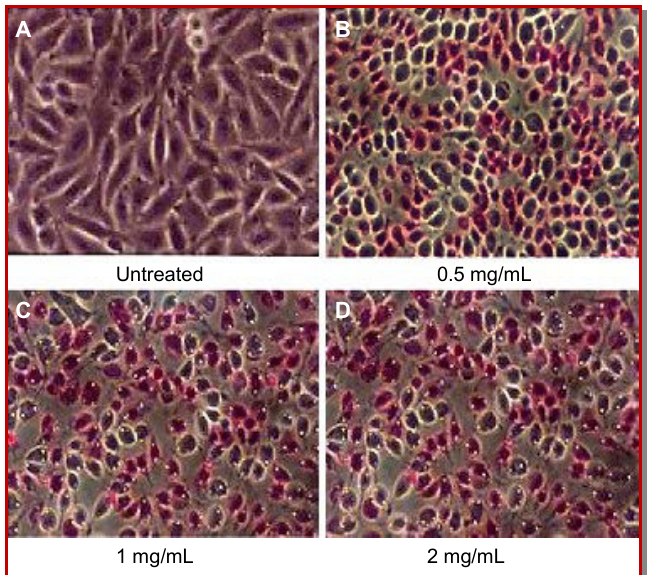
Figure 1: The APOPercentage  apoptosis assay showing CHO cells treated with T. violacea crude aqueous extract stain positive for apoptosis. (A) shows the untreated control cells which did not stain the purple-red, (B, C and D) show cells that have been treated with 0.5, 1 and 2 mg/mL respectively of T. violacea crude aqueous extract and stain purple-red